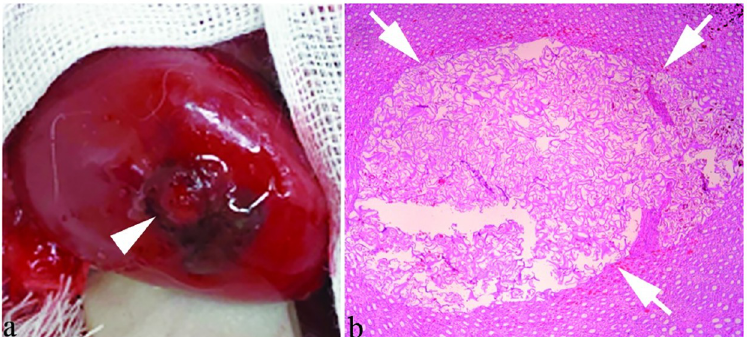
Fig 5. Rabbit kidney after tract embolization with gel-like embolic material. a) Macroscopic image shows overflow of gel-like embolic material (white arrowhead) from the puncture site. b) Microscopic image of renal parenchyma shows the punctured tract entirely filled with injected gel-like gelatin sponge particles (white